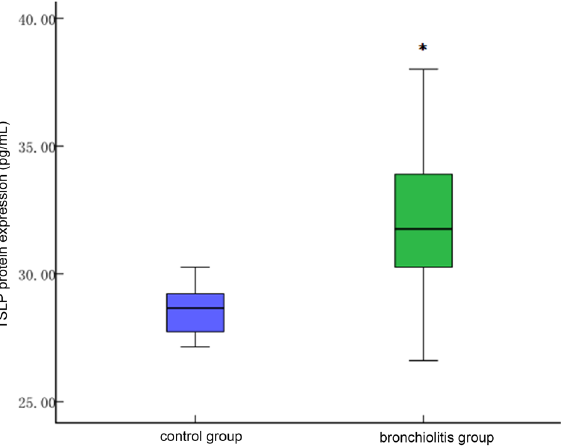
Figure 5. TSLP protein levels in peripheral blood between control group and bronchiolitis group. The protein expression level of TSLP in bronchiolitis group was higher than control group, which is in consistent with mRNA level (* P < 0.05).